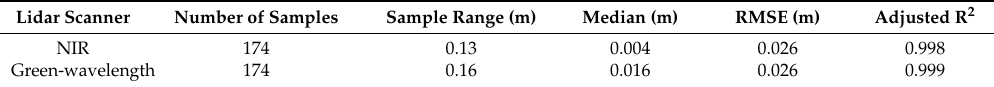
Table 3. GPS post-processing quality-control findings (vertical adjustment).